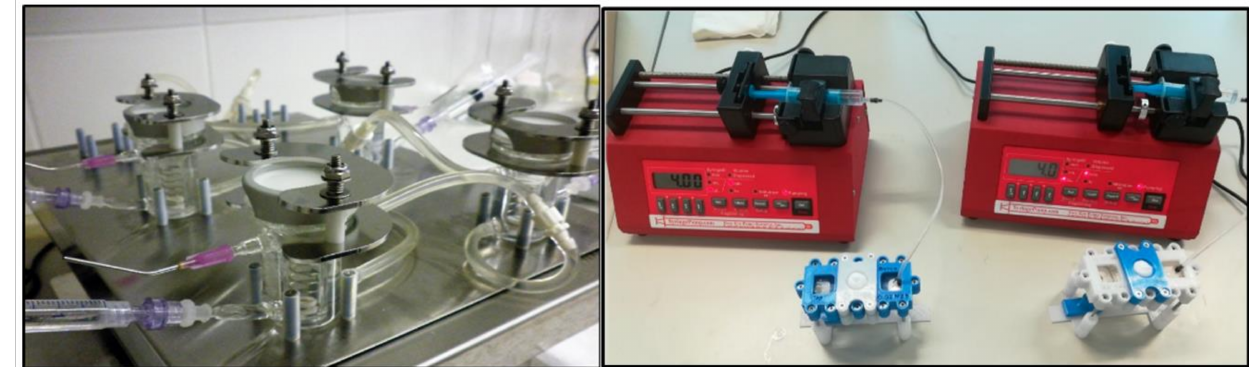
Figure 3. The static Franz diffusion cells ( left ) and the dynamic skin-on-a-chips ( right ). Both in the Franz cell and the skin-on-a-chip, the direction of the diffusion is vertical, but while in the Franz cell there is continuous stirring with a helical stirrer, in the chip, there is a continuous flow of the perfusion fluid below the skin